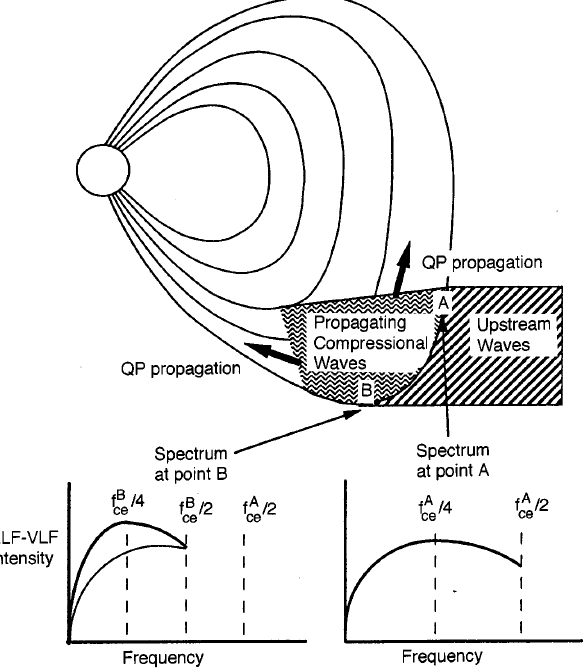
Fig. 17. A model of magnetic field lines and the source region of the Type 1 QP emissions (reproduction of Fig. 11 of Alford et al ., 1996). In this schematic version of the Tsyganenko (1991) magnetic field model the field magnitude is minimum in the ‘‘horn,’’ where whistler waves are most easily excited. The growth rate of the whistler waves is modulated by Pc 3–4 waves that originate in the upstream region and propagate into the magnetosphere with compressional magnetic field